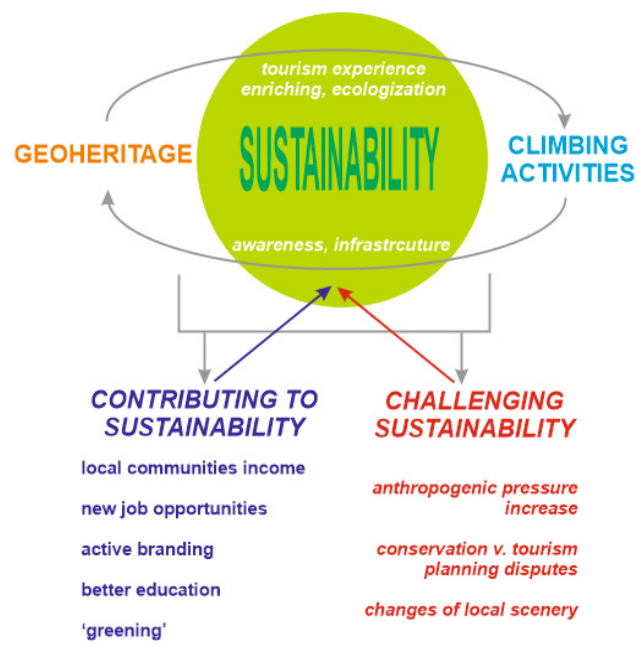
Figure 3. Relationship of geoheritage management (including geotourism) and climbing activities to sustainability.